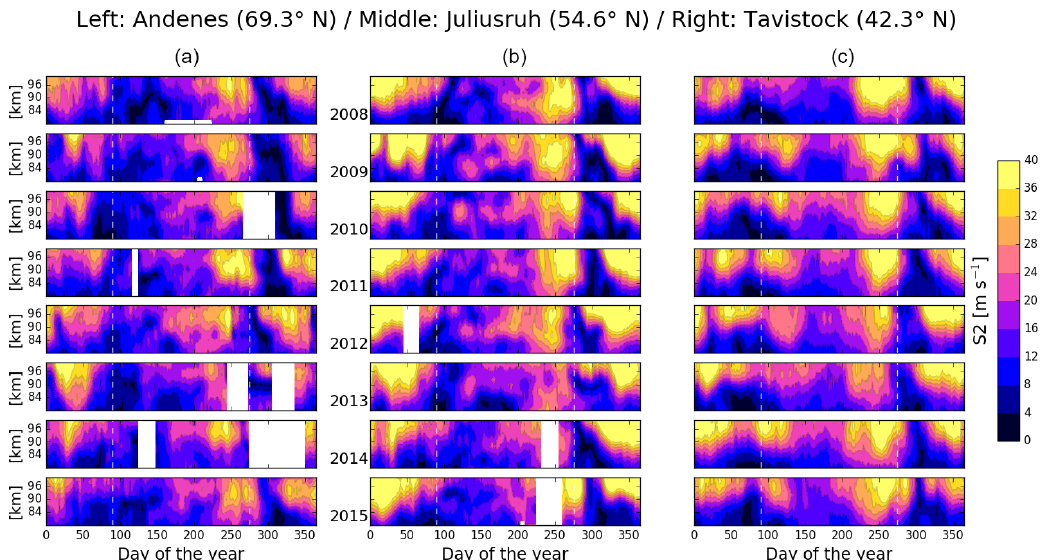
Figure 2. Semidiurnal solar tide (S2) observed during the time period (from top to bottom) 2008–2015, over (column a ) Andenes, (column b ) Juliusruh and (column c ) Tavistock. Data gaps are shown in white. The vertical white dashed lines indicate DoYs 90 and 275. The selected years correspond to the period with available data at the three